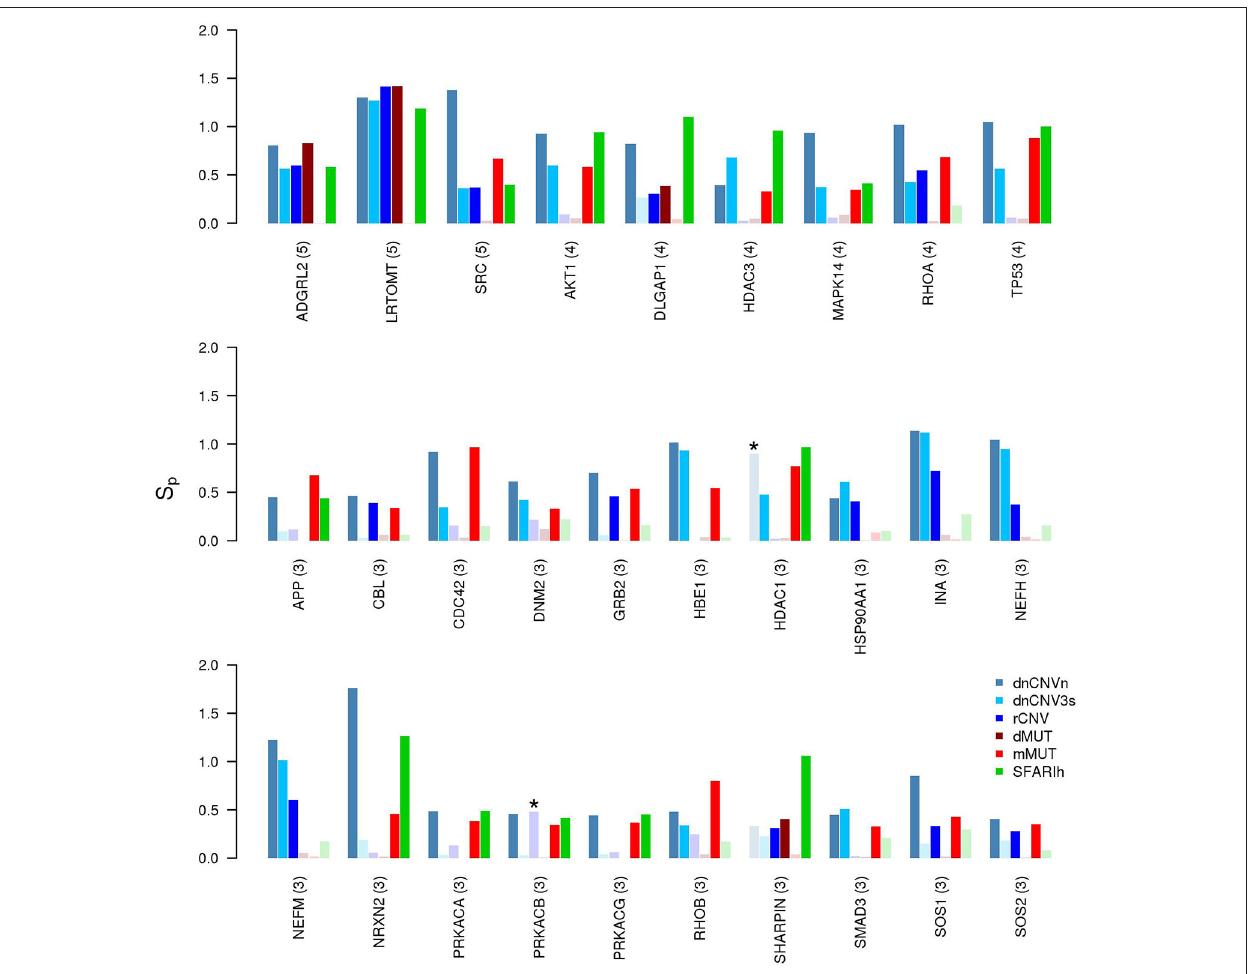
FIGURE 4 | Genes in network proximity to ASD risk genes from 3 or more studies. Permutation-adjusted network smoothing index ( Sp ) of the 29 genes predicted as functionally related to 3 or more ASD risk gene lists (the number is reported between parenthesis); the asterisk (*) indicates genes of the corresponding original list; faded colors indicate input ASD risk genes or genes with no significant Sp